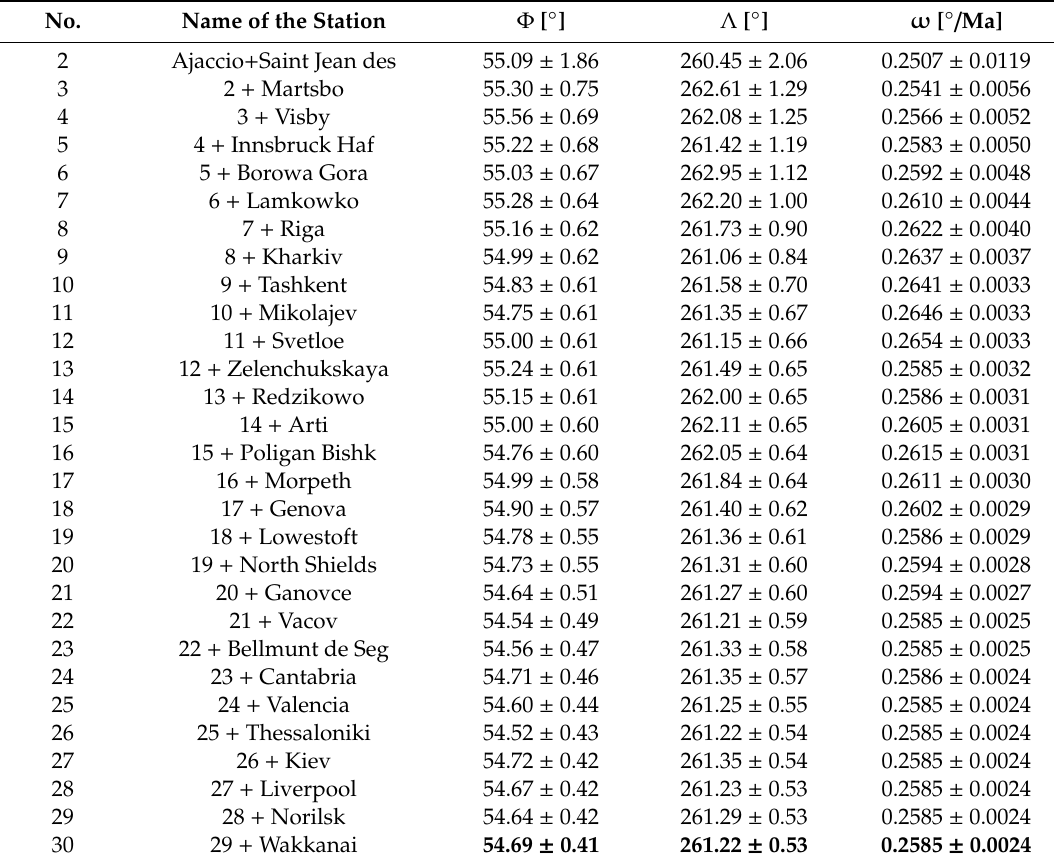
Table A4. Computed plate motion parameters, and their errors, of the Eurasian plate for the GNSS network using the sequential method. Scenario 4 of the